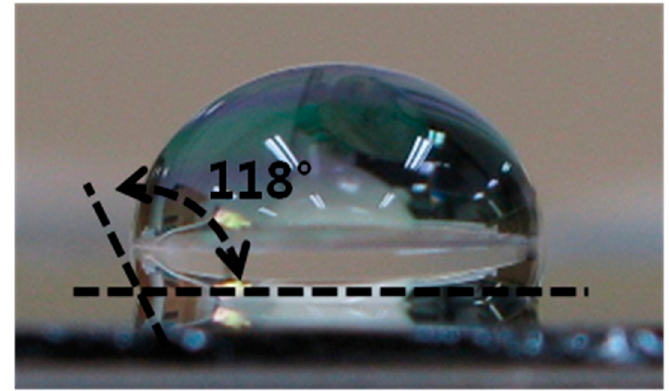
Figure 8. The contact angle of the upper protective coating with 2-Layer (Teflon/SU-8).